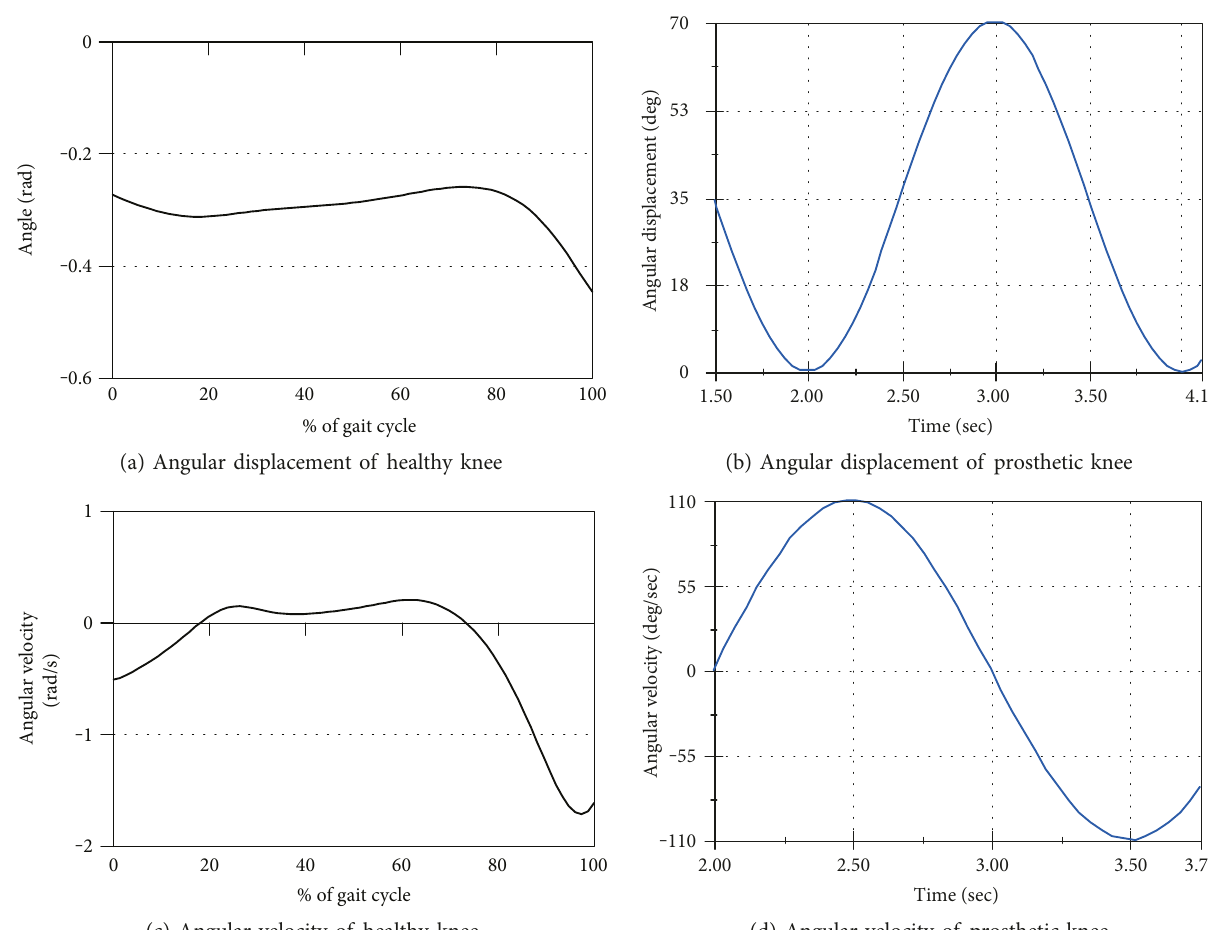
Figure 5: Angular displacement and angular velocity of the knee joint obtained from a healthy subject and from motion analysis of the prosthetic knee